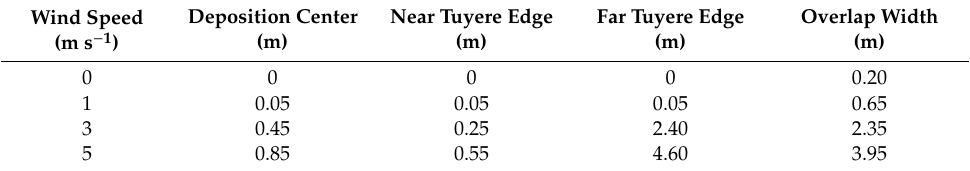
Table 3. Droplet drift distance of deposition center, near tuyere edge, far tuyere edge, and overlap